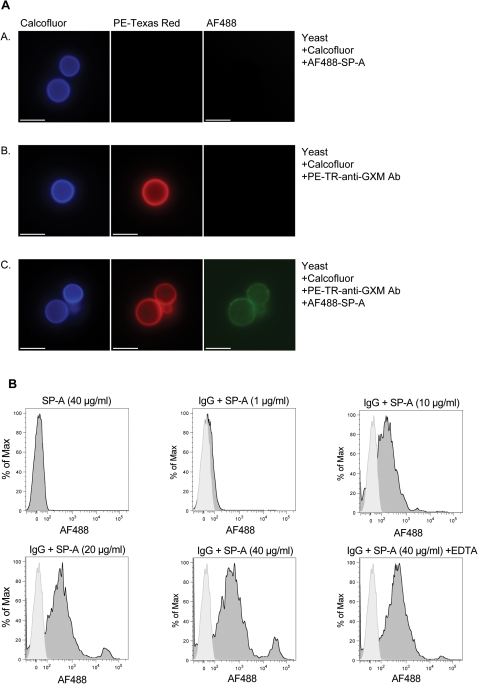
SP-A can bind C. neoformans via an IgG dependent mechanism.(A.) C. neoformans yeast (1×105) were treated with AF488 labeled SP-A (Panel A), PE-Texas Red labeled anti-GXM IgG (Panel B) and PE-Texas Red labeled anti-GXM IgG and AF488 labeled SP-A (Panel C). Calcofluor was added to all samples to visualize the cell wall. SP-A binding to IgG opsonized (Panel C) but not non-opsonized (Panel A) C. neoformans was observed. Scale bar length is equal to 10 µm. (B.) IgG opsonized C. neoformans were treated with SP-A concentrations of 1, 10, 20, 40 µg/ml and binding was quantified by flow cytometric analysis. EDTA (1 mM) was included to determine if SP-A binding required the carbohydrate recognition domain. Histograms represent the mean fluorescence intensity of the AF 488 channel. At least 10,000 particles were interrogated for each sample.